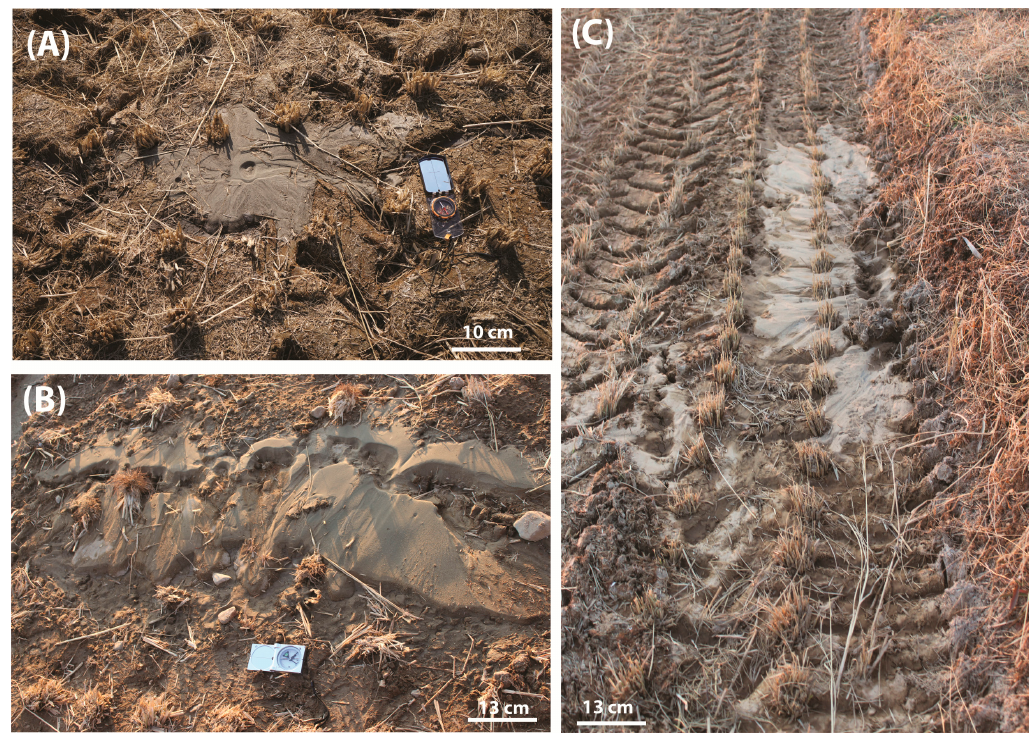
Figure 5. Typical field photos showing different types of liquefaction feature observed during the Pohang earthquake. ( A ) Isolated sand boil in the rice field. ( B ) Chain/Clustered sand boils in the rice field. ( C ) Sand/gravel mixtures ejected using preexisting cracks.